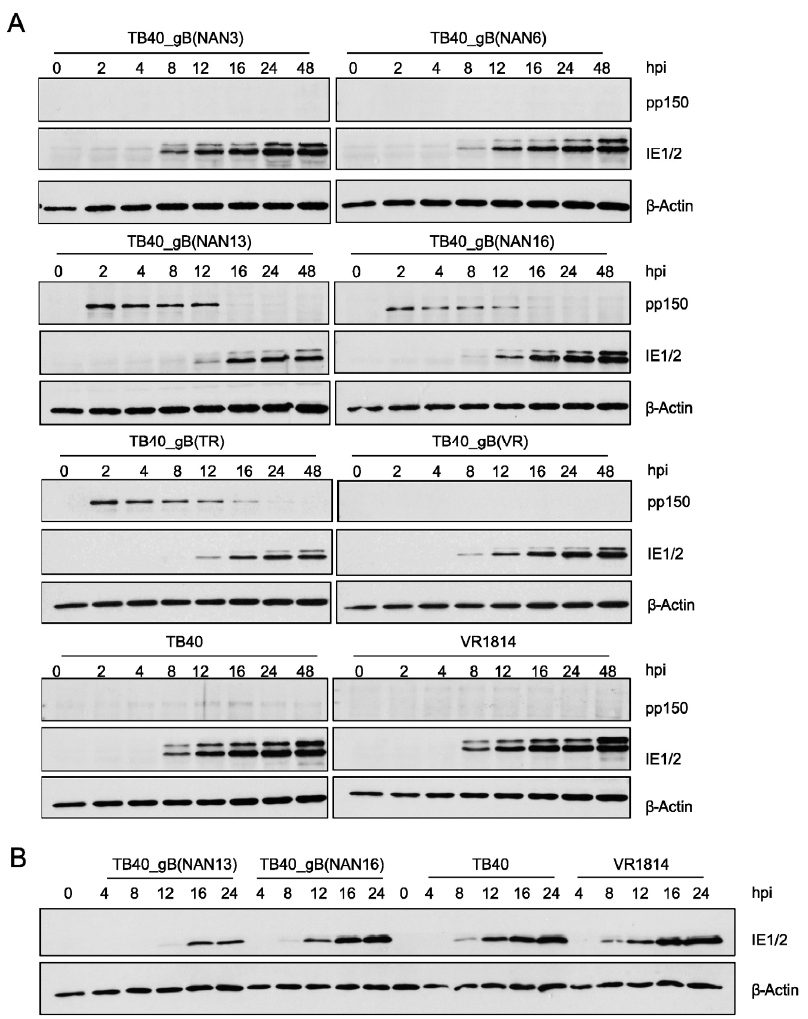
Figure 6. Infectivity of recombinant TB40 strains. ( A ) MRC5 cells were HCMV-infected at an MOI of 0.5. The viral tegument protein pp150 and the IE1 and IE2 proteins were detected by immunoblot analysis. ( B ) For better comparison, selected samples shown in panel A were separated and analyzed on the same polyacrylamide gel. hpi, hours post-infection.